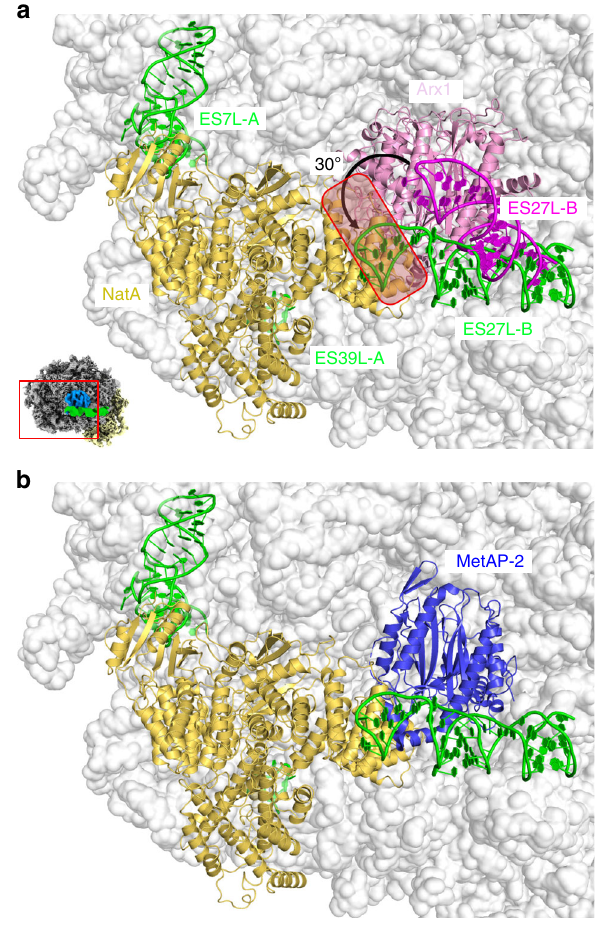
Fig. 5 PA2G4 proteins as MetAP-2 structural homologs. a Structure of the NatA – ribosome complex from yeast 25 (PDB ID: 6HD7) superposed with Arx1 – ES27L (in pink tones) taken from the Arx1 – ribosome complex 14 (PDB ID: 5APN). ES27L-B was built de novo in this study. The C-terminal region of Arx1 clashes (boxed region) with the Naa10 subunit, and ES27L-B conformation is different (arrow). The view is identical to Fig. 1c top panel, and as indicated by the small representation in the corner. b Proposed model for simultaneous MetAP-2/NatA binding in eukaryotic co- translational protein modi fi cation based on the yeast NatA complex and